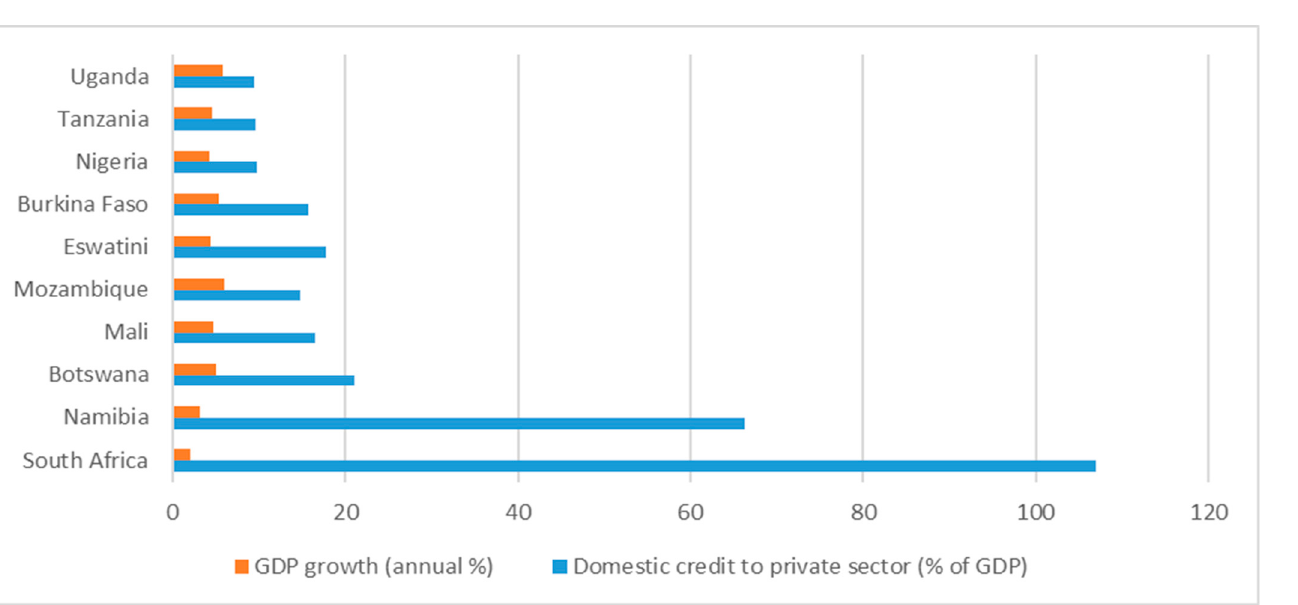
Figure 1. Graphical analysis of the mean of financial development and economic growth from 1985 to 2021. Source: Authors’ illustration based on WDI (2022).